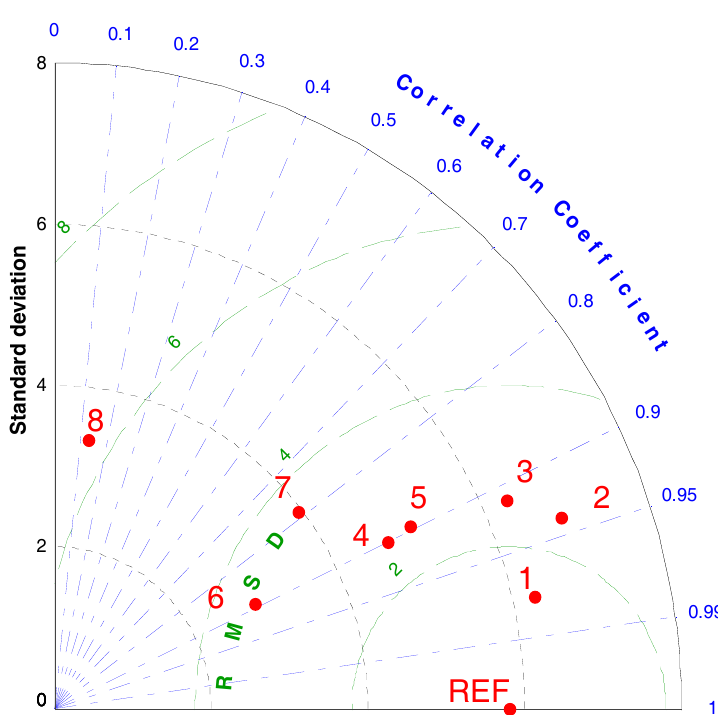
Figure 1. Taylor Diagram displaying the statistical comparison of 30-year SLP means considering the relative differences of eight CMIP5 models ((1) MOHC: HadGEM2ES; (2) NCAR: CCSM4; (3) CCCMA: CanESM2; (4) MPI-M: MPI-ESM-LR; (5) FIO: FIO-ESM; (6) MIROC: MIROC5; (7) IPSL: IPSL-CM5A-LR; (8) CSIRO-QCCCE: CSIRO-Mk3.6.0) with respect to SLP reanalysis values (REF). Models are ranked and numbered based on their relative performances. The SLP means were selected over the geographical area covering the Baltic Sea and the North Sea. The green arcs represent root mean square differences (RMSD), black arcs show standard deviation values and blue lines indicate correlation values.